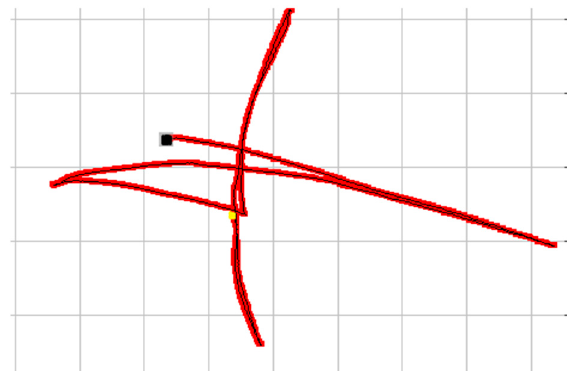
Figure 23. The path in Figure 21 shown by Tracker.